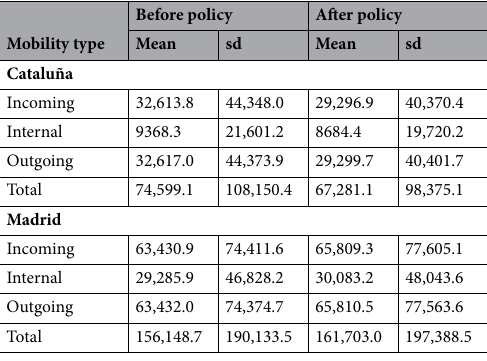
Table 3. Summary statistics.